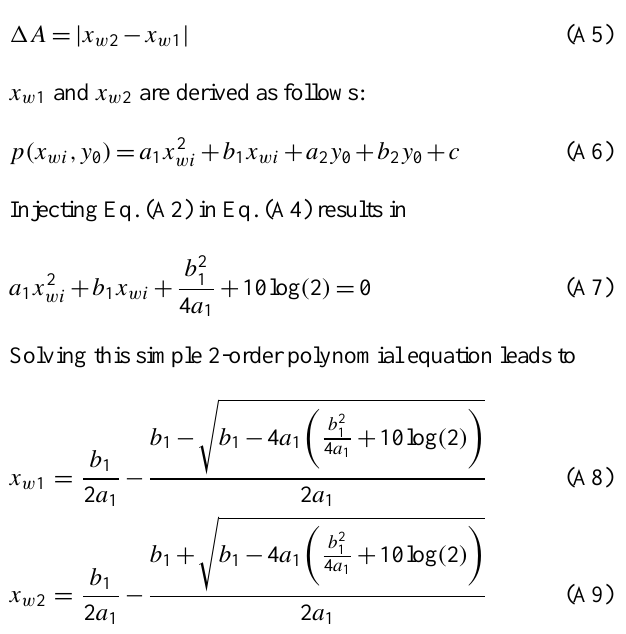
Table 2. Modeling of the non-negligible instrumental errors.